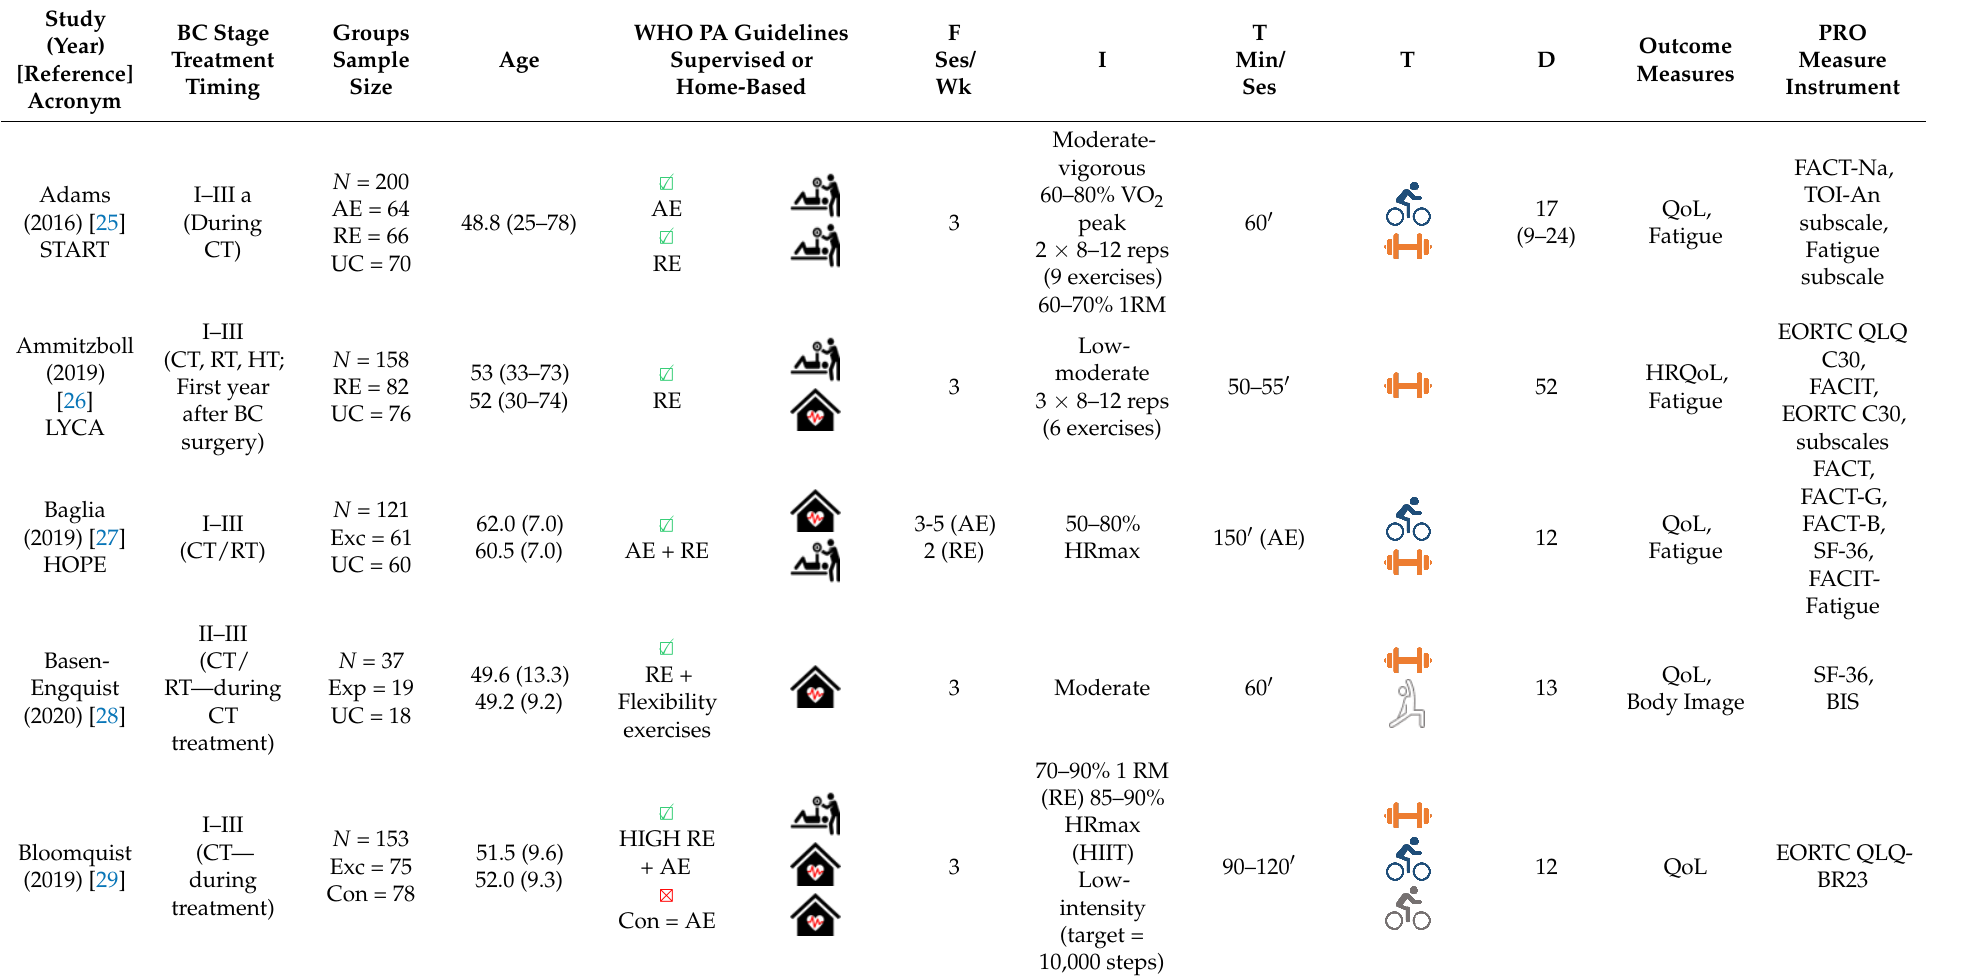
Table 2. Characteristics of the studies includes.